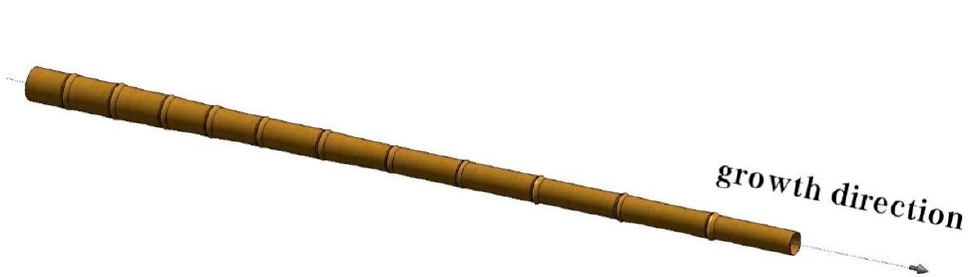
Figure 4. Distribution of bamboo nodes along the growth direction of bamboo stalks.